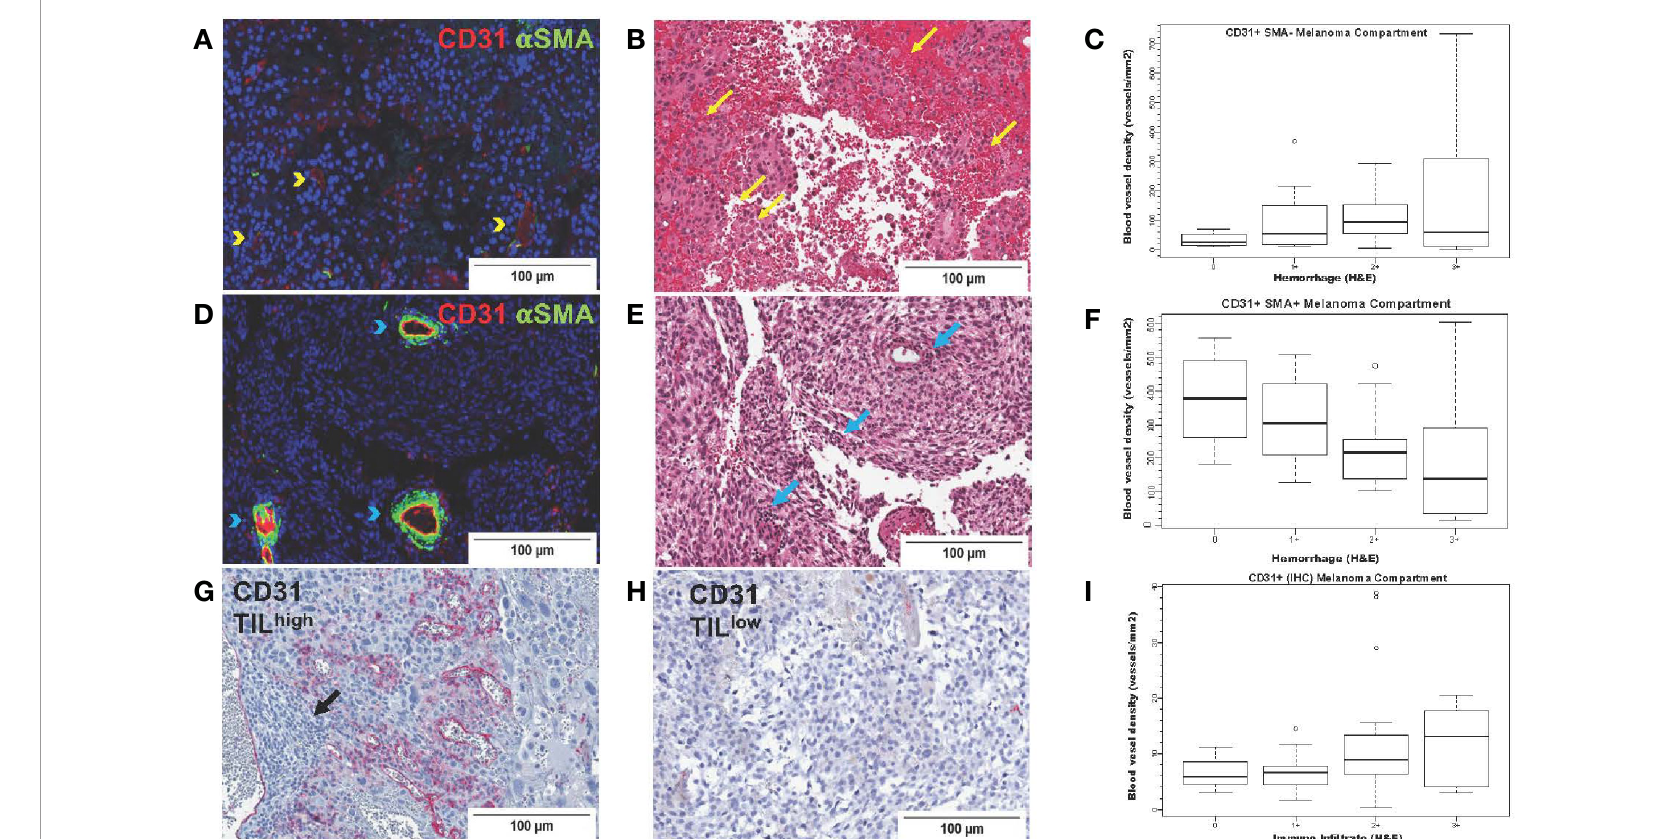
FIGURE 5 | CD31 blood vessel density in melanoma brain metastases from the University of North Carolina at Chapel Hill craniotomy cohort. Images in the upper row (A – C) correspond to immature blood vessels (CD31+ a SMA-); middle row images (D – F) correspond to mature blood vessels (CD31+ a SMA-); lower row images (G – I) correspond to total (CD31+) blood vessels. Digital images that correspond to representative tissue sections stained with antibodies against CD31 [pseudocolored with red, (A, D) ] and a SMA [pseudocolored with green, (A, D) ] by two-color immuno fl uorescence (IF) and by CD31 by single-color immunohistochemistry (G, H) are shown. Tissue slides stained by two-color IF were subsequently stained with hematoxylin and eosin (H&E) (B, E) . Areas with CD31+ a SMA- blood vessels [yellow arrowheads, (A) ] trend ( p =0.07) to have high intratumoral hemorrhage [yellow arrows, (B) ], whereas areas with CD31+ a SMA+ blood vessels [blue arrowheads, (D) ] have signi fi cantly low/absent intratumoral hemorrhage [blue arrows, center image, (E) ]. Areas with high [black arrows, (G) ] versus low density of tumor-in fi ltrating lymphocytes (TILs) (H) are also shown. Boxplots showing correlation between blood vessel density of immature [CD31 + a SMA-, (C) ] and mature [CD31+ a SMA+, (F) ] blood vessels with hemorrhage. (I) shows density of CD31+ blood vessels with TILs